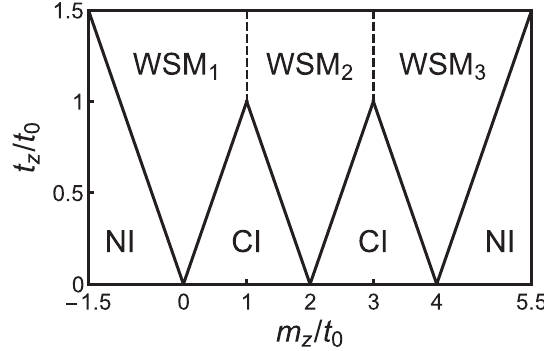
FIG. 4. The phase diagram of the clean noninteracting tight- binding model defined through Eqs. (5) and (3). Here, NI and CI, respectively, represent trivial (normal) and Chern insulators. Weyl nodes in the WSM phase are always located along the k z direction. Respectively, WSM 1 supports one, two, and one ; 2 ; 3 pair of Weyl nodes. The projection of the Weyl nodes on the xy plane in these phases are at the (0,0) point, ð 0 ; π Þ and ð π ; 0 Þ points, and ð π ; π Þ point. This model therefore supports transla- tionally active topological phases [9,78]. The transitions between the WSM and insulating phases (solid lines) and the ones between two distinct WSM phases (dashed lines) are continuous. We emphasize that there is no symmetry distinction among these